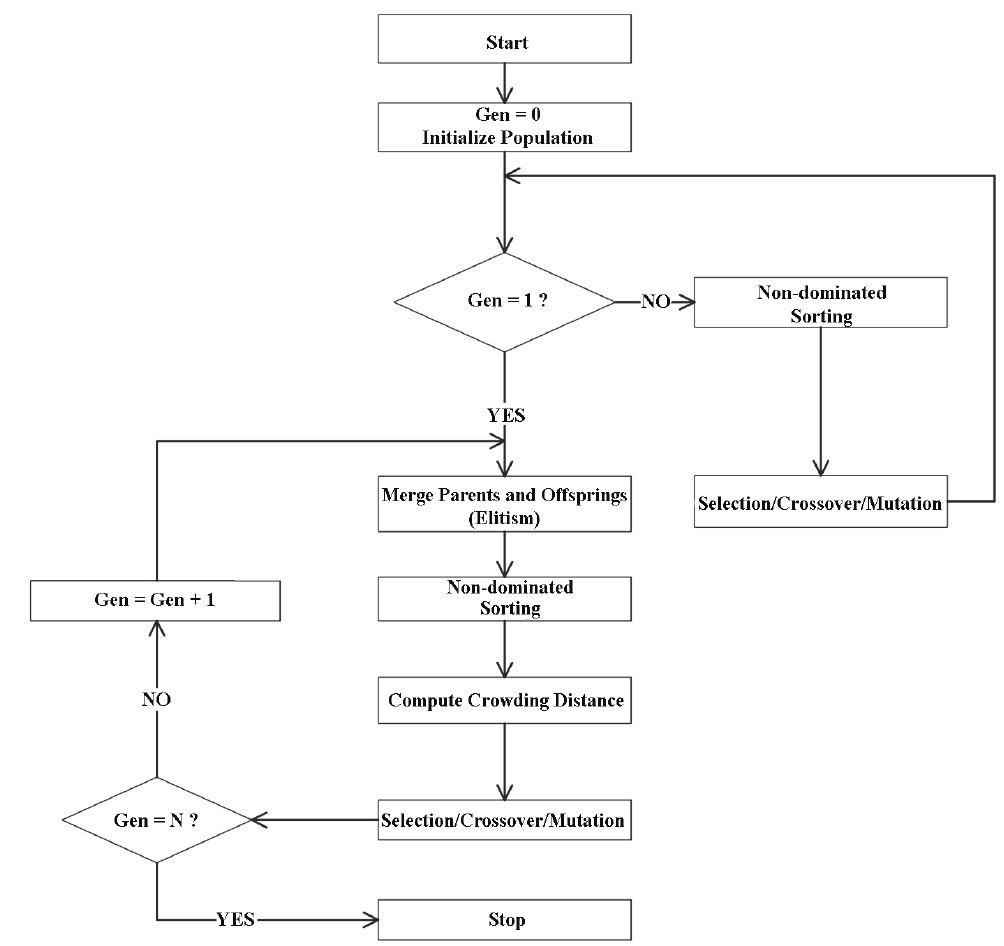
Figure 2. Operation process of NSGA-II